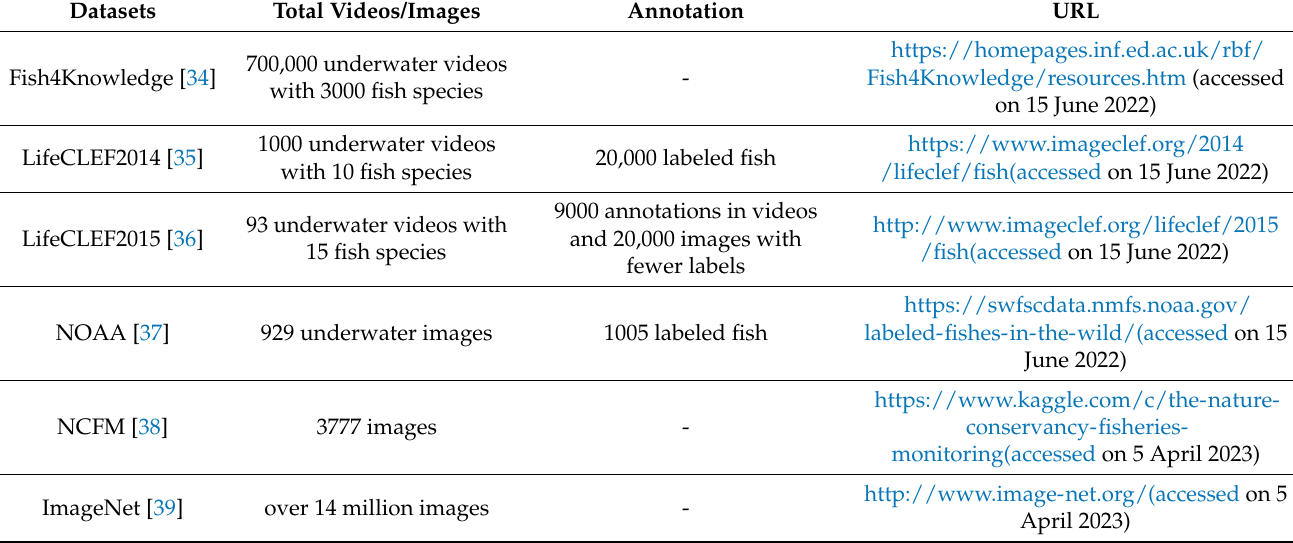
Table 1. The public datasets for